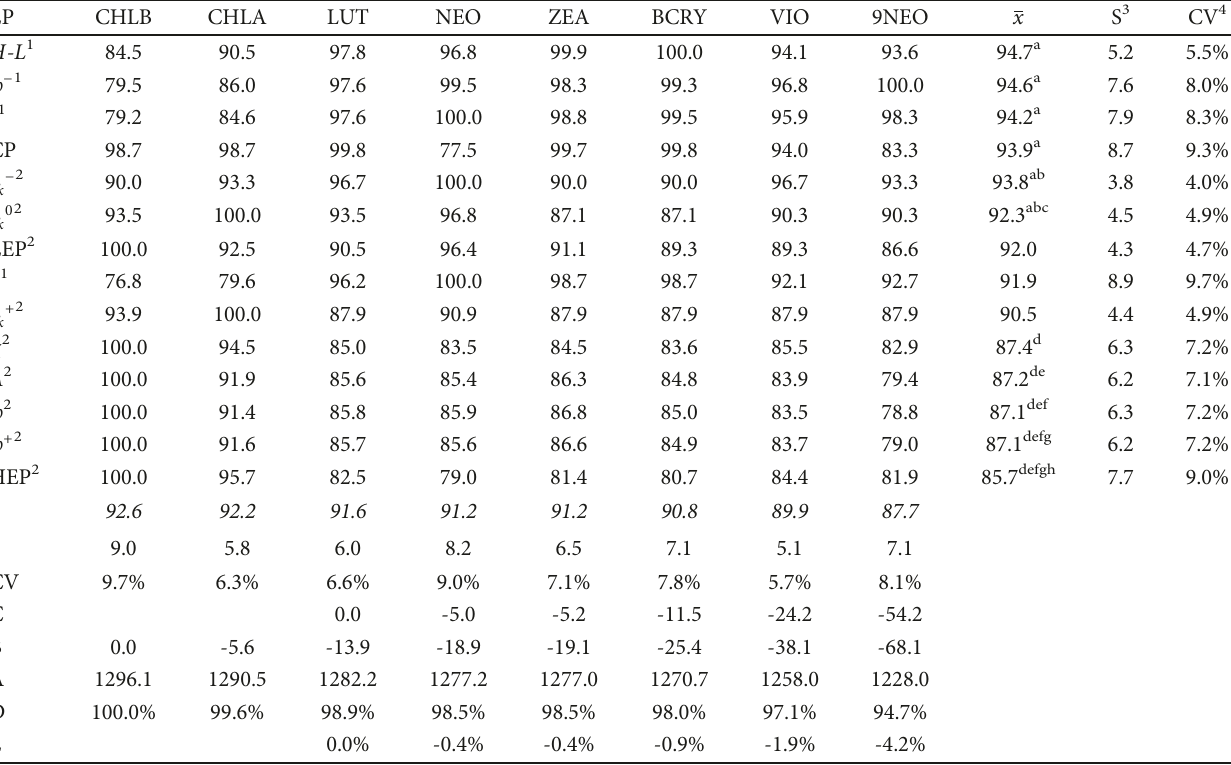
Table 3: Points obtained by each molecule according to the suitability of its electronic properties (EP). EP CHLB